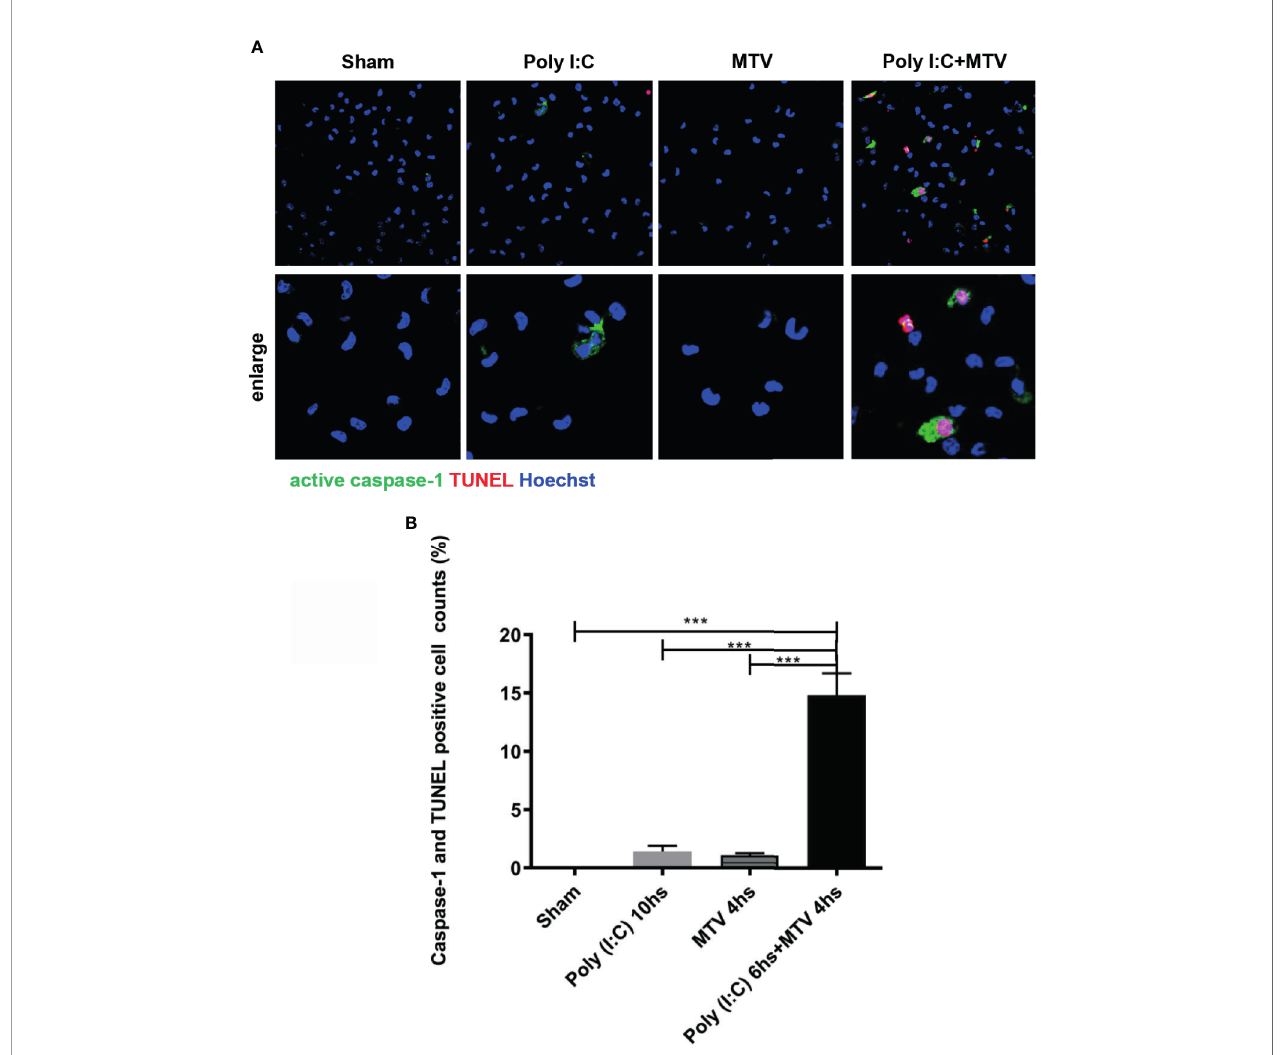
FIGURE 8 | MTV induced alveolar macrophage pyroptosis after Poly(I:C) priming. Alveolar macrophages on and maturation and release of cytokines in combined Poly(I:C)-MTV injury model. The gut-lung axis resulted in activation of pulmonary non-canonical (cytosolic mediated caspase-11 activation) and canonical (Caspase-1) in fl ammasome (NLRP3) mediated ALI in this two hit model resulting in GSDMD sensitive alveolar capillary barrier disruption, pyroptosis (in alveolar macrophages) and cytokine maturation and release (IL-1 b ; IL-18) were isolated immediately after mice scari fi cation and adhere for at least 2 hours before staining. Caspase-1 activation was labeled with FLICA caspase-1 and DNA fragmentation was labeled with TUNEL by confocal microscopy (A) . Quanti fi cation was done by Image J (B) . Results are shown as means ± SEM (n=12) and compared by one-way ANOVA and Student-Newman-Keuls test. *** p <